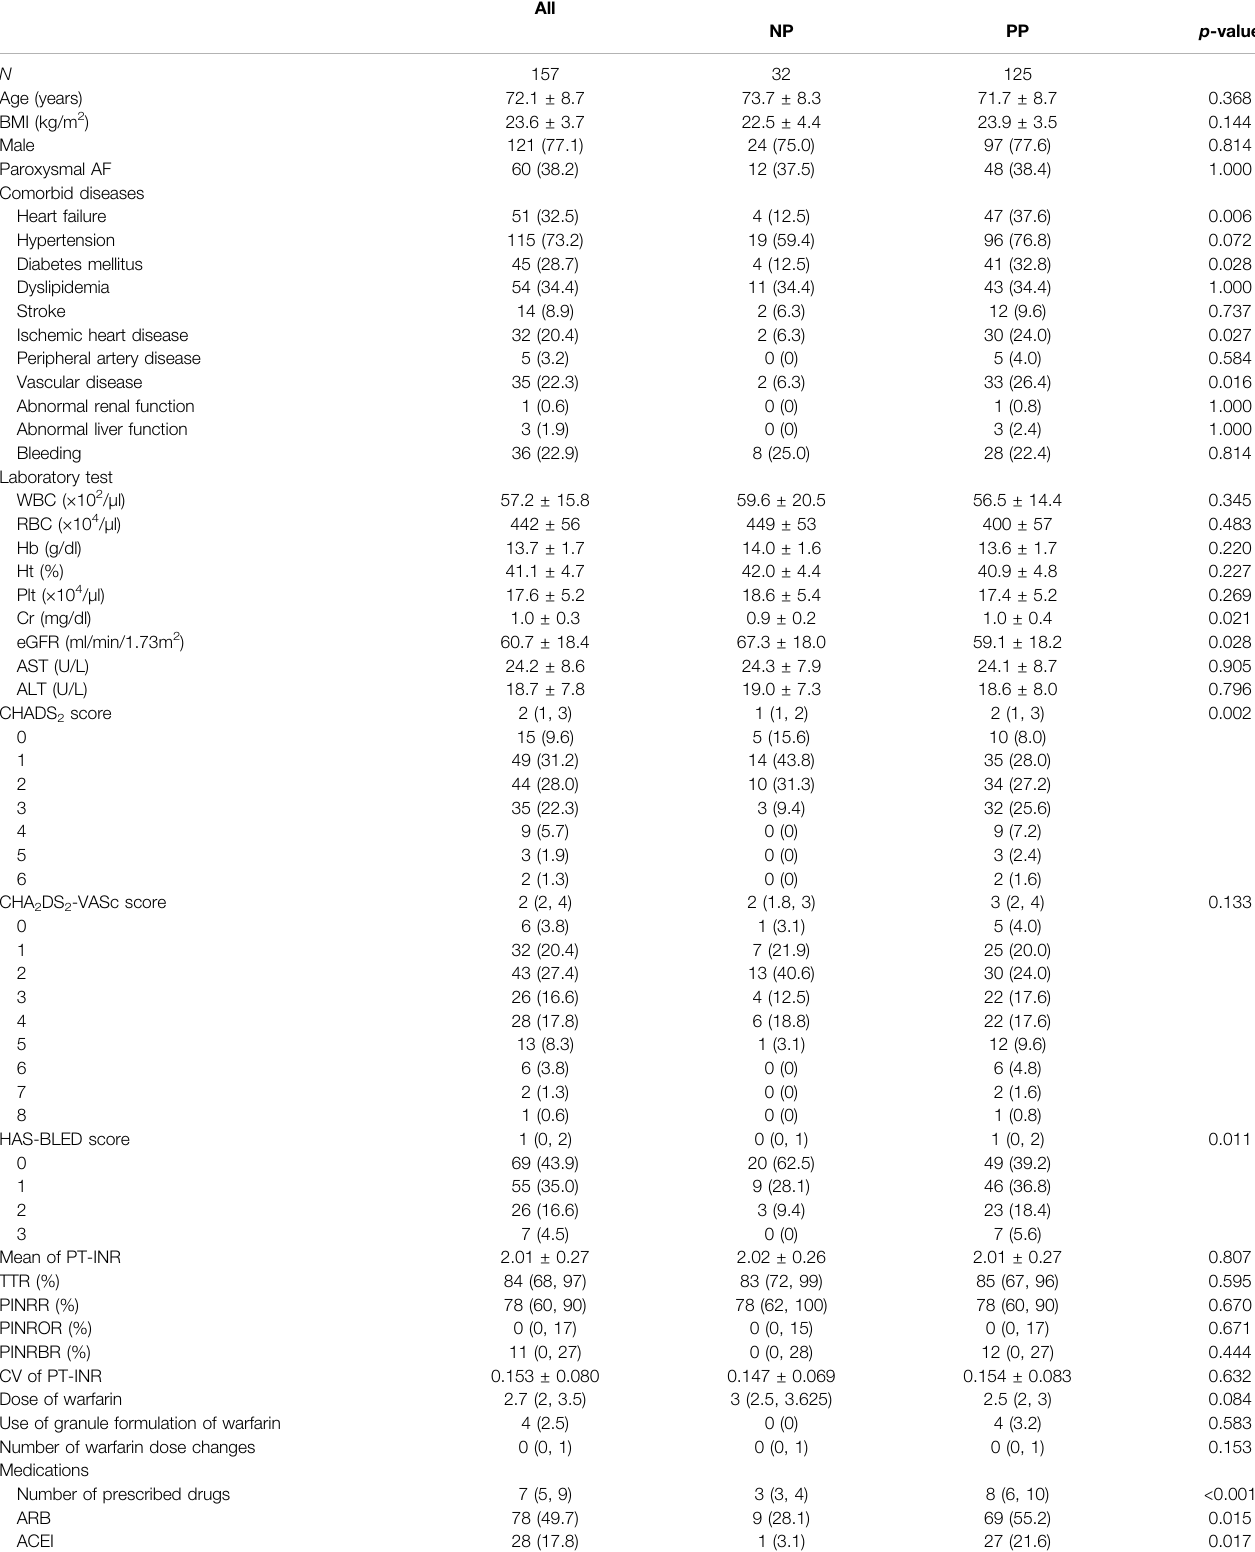
TABLE 1 | Clinical